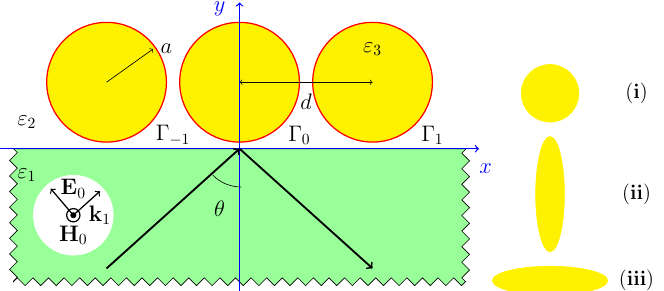
Figure 1. Periodic set of circular cylinders near the interface between free space and glass. Inset describes the considered cross-sectional shapes: ( i ) circle, ( ii ) vertical ellipse, ( iii )